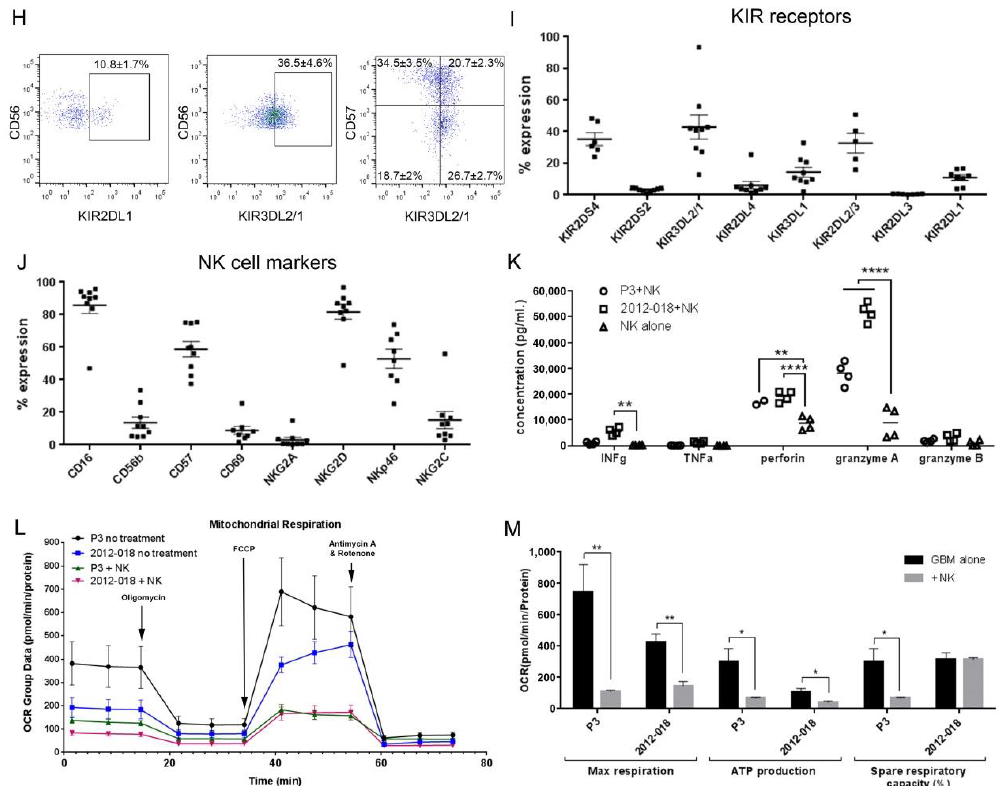
Figure 1. The effect of treatment with natural killer (NK) cells against glioblastoma (GBM). ( A ) A gating strategy for cytotoxicity assays showing analysis from left to right of cells, singlets, separation of effector (NK cells) and target (GBM cells) cells, and gating on live cells. The % fraction of surviving cells determined from flow cytometry analyses in ( B ) K562 cells treated with 5:1 of allogeneic NK cells; ( C ) P3, 2012-018 and BG7 GBM cells treated with 5:1, 10:1 and 20:1 of allogeneic NK cells; and ( D ) BG7, BG9 and BG8 GBM cells treated with autologous 5:1 of NK cells. ( E ) % cell lysis, as determined from flow cytometry, of P3 and BG8 GBM cells after allogeneic 5:1 NK cells alone and 5:1 NK cells inhibited with anti-asialo-GM1. ( F ) The % expression, determined with flow cytometry, of NKG2D ligands, CD112 and TRAIL-R2 in untreated P3, 2012-018, BG7 and BG8 cells. ( G ) ULBP3 histograms in P3 (left) and BG7 (right) cells (control Fluorescent Minus One (FMOs) dark grey and stained sample light grey). ( H ) Dot plot showing (from left to right) CD56 vs. KIR2DL1, CD56 vs. KIR3DL2/1 and CD57 vs. KIR3DL2/1 in representative NK cells. The % expression of ( I ) killer immunoglobulin-like receptors (KIR) receptors and ( J ) NK cell markers on donor-derived-NK cells. ( K ) ELISA to determine concentration in pg/mL of IFNγ TNF perforin and granzymes A and B in supernatant of P3 and 2012-018 cells treated with allogeneic NK cells and NK cells alone. ( L ) Profile from the Seahorse assay for mitochondrial respiration based on the oxygen consumption rate (OCR) and sequential drug injection for P3 and 2012-018 GBM cells alone and treated with allogeneic NK cells. ( M ) Graph showing measurements of maximal respiration, ATP production and spare respiratory capacity of P3 and 2012-018 cells alone (black) and treated with allogeneic NK cells (grey). Data represents the mean ± SEM of n = 3 independent experiments. Two-way ANOVA, Bonferroni’s multiple comparison test, * p < 0.05; ** p = 0.01; *** p < 0.001; **** p < 0.0001. NK and tumour cells were examined for expression of molecules involved in NK-mediated lysis. Greater proportions of P3 and 2012-018 cells expressed MICA and ULBPs, whereas BG7 cells expressed MICB and CD112 (Figure 1F,G), which are stress ligands recognized by NKG2D and DNAM-1 NK-cell-activating receptors, respectively. The KIR – HLA ligand interactions were investigated based on genotype, where licenced and potentially functional subsets were identified